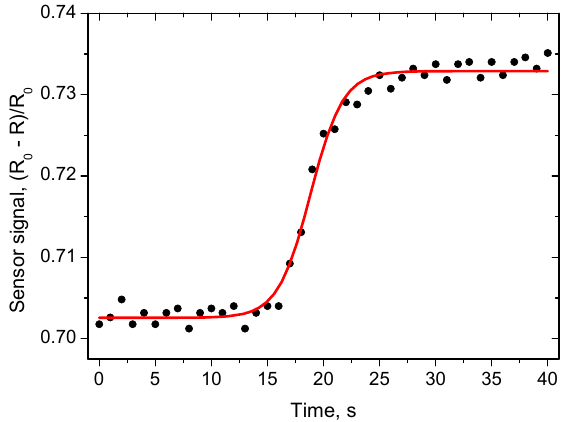
Figure 13. Response time of the sensor to change of humidity: air, RH70 ⇒ air, RH80; Sensor signal is calculated as (R 0 − R)/R 0 , where R 0 is the sensing layer resistance in dry air and R is resistance in air with current humidity. Response time to changing humidity is ~10 s ( τ 90 —time necessary to reach 90% of final value of conductivity).